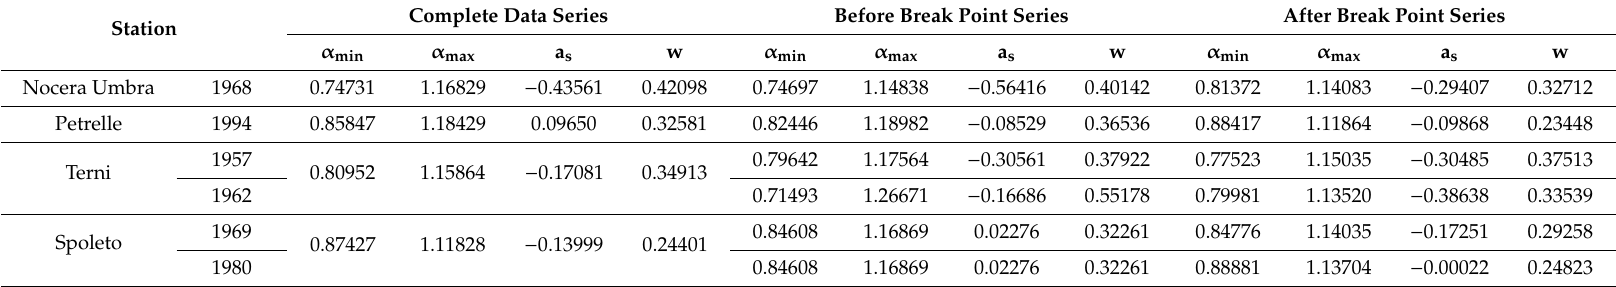
Table 6. Main results obtained for the multifractal spectrum of the extreme rainfall data series for which break points were detected by the statistical tests. Complete Data Series Before Break Point Series Station Nocera